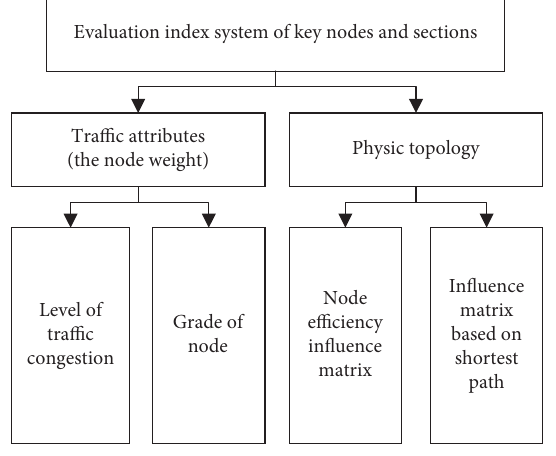
Figure 2: Evaluation index system of key nodes and